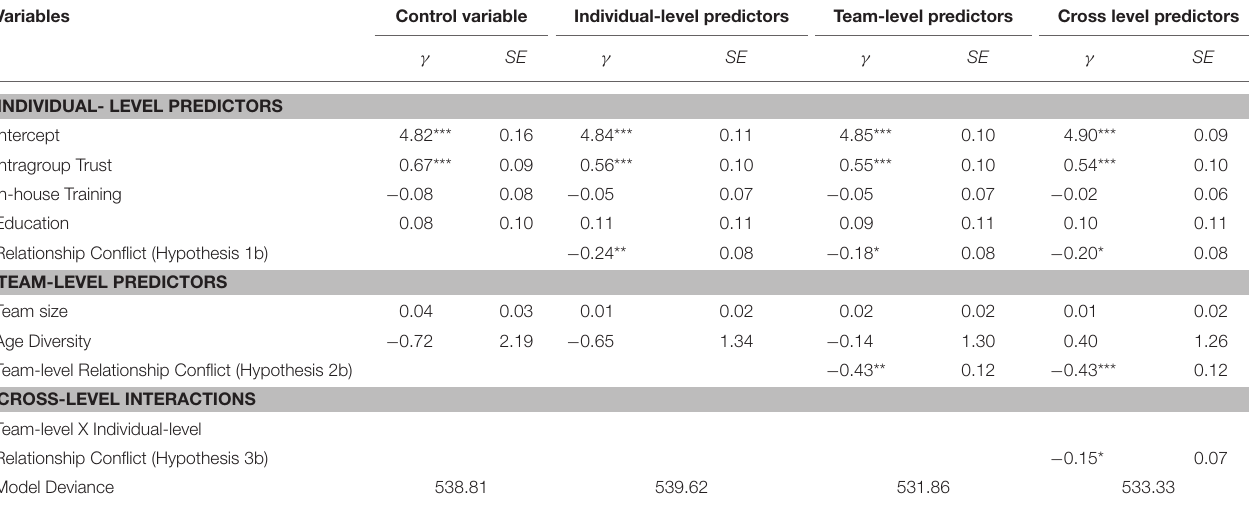
TABLE 4 | HLM results for the effects of relationship conflict on team